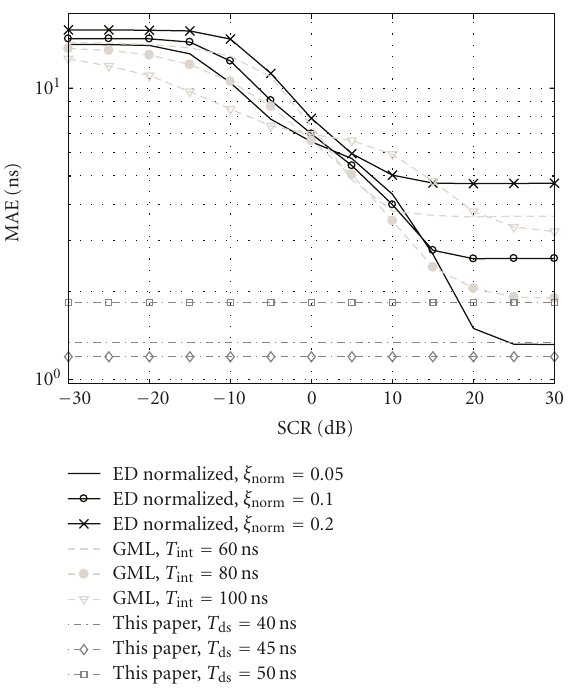
Figure 7: Performance comparison of di ff erent TOA estimators in CM1: (1) ED estimator with normalized threshold (solid line); (2) estimator derived based on GML criterion (dash line); (3) the estimator proposed in this paper (dash-dot line). The settings are E s /N 0 = 35dB, N s = 8, N f = 4, Δ = 1ns, T GML = 1ns, and T ED = 1ns, T sb =